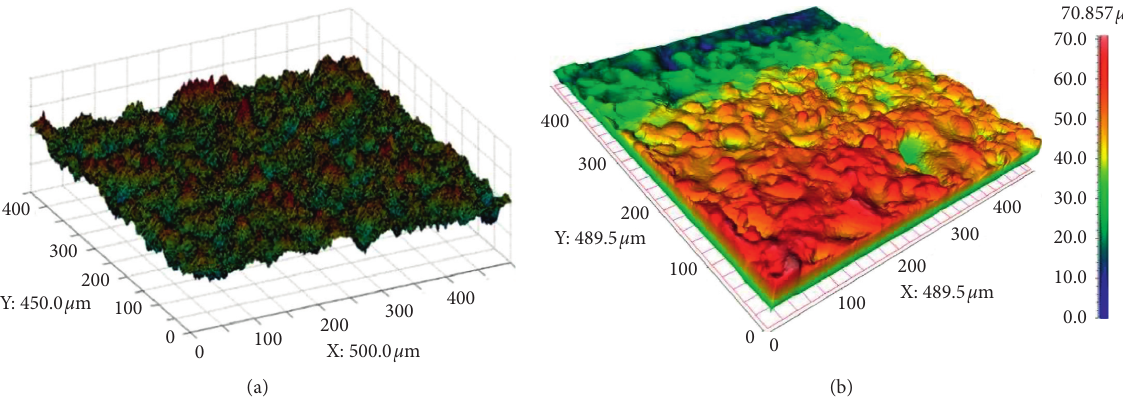
Figure 5: Experimental and simulated surface topographies: (a) simulated result; (b) experimental result.